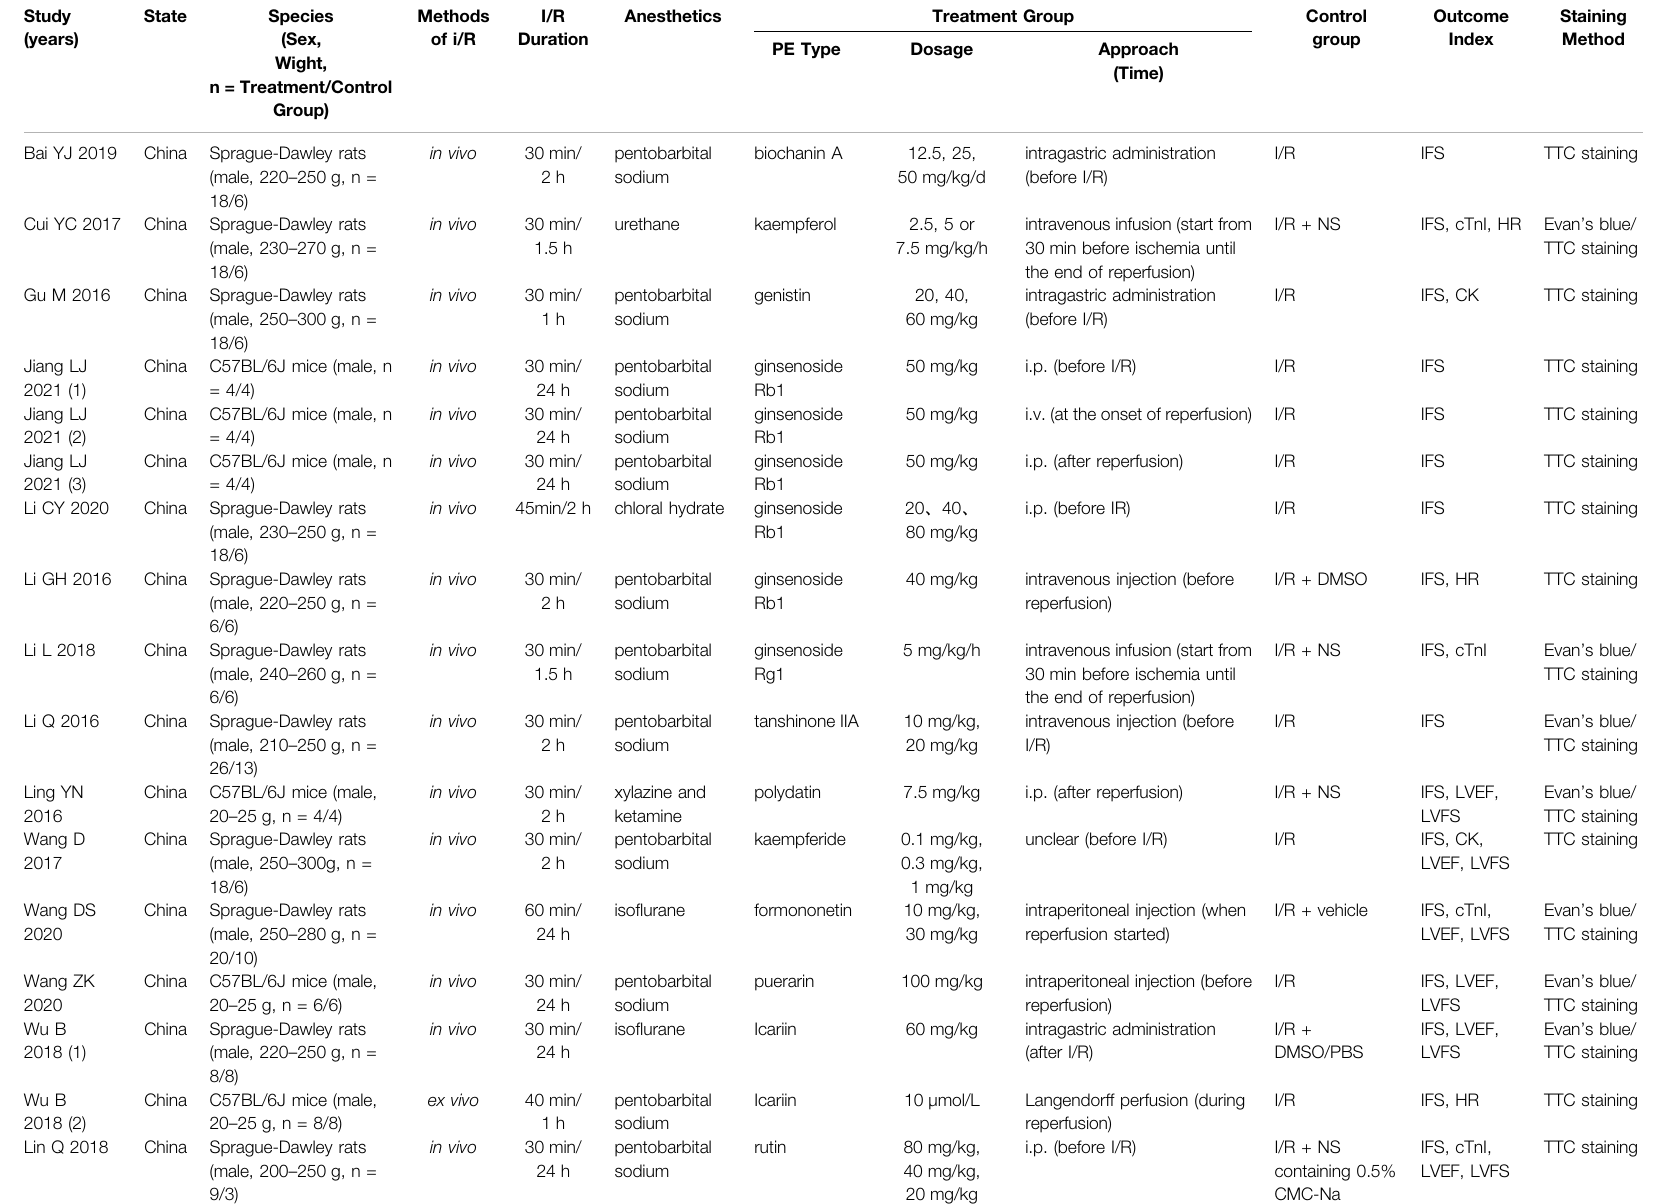
TABLE 2 | Characteristics of the included